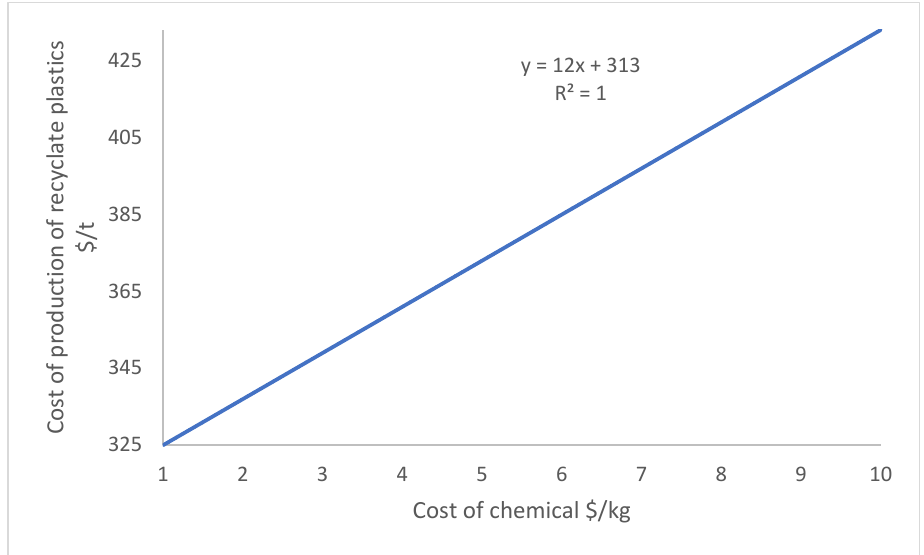
Figure 9. The effect of chemical cost on the cost of production of recyclate plastics.